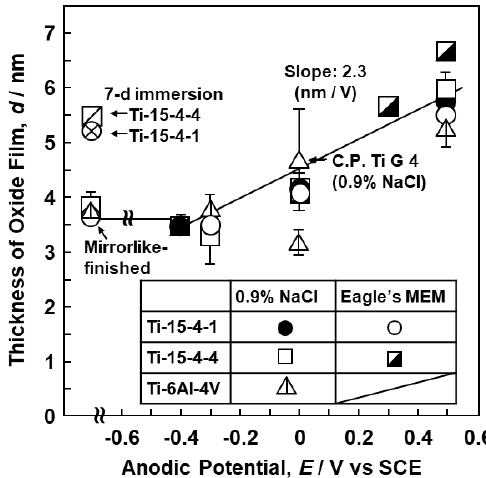
Figure 7. E ff ect of anodic polarization on thickness of oxide films formed by anodic polarization on surfaces of Ti–15Zr–4Nb–4Ta, Ti–15Zr–4Nb–1Ta, and Ti–6Al–4V alloys and C.P.-Ti G-4 in 0.9% NaCl or Eagle’s MEM solution at 37 °C.